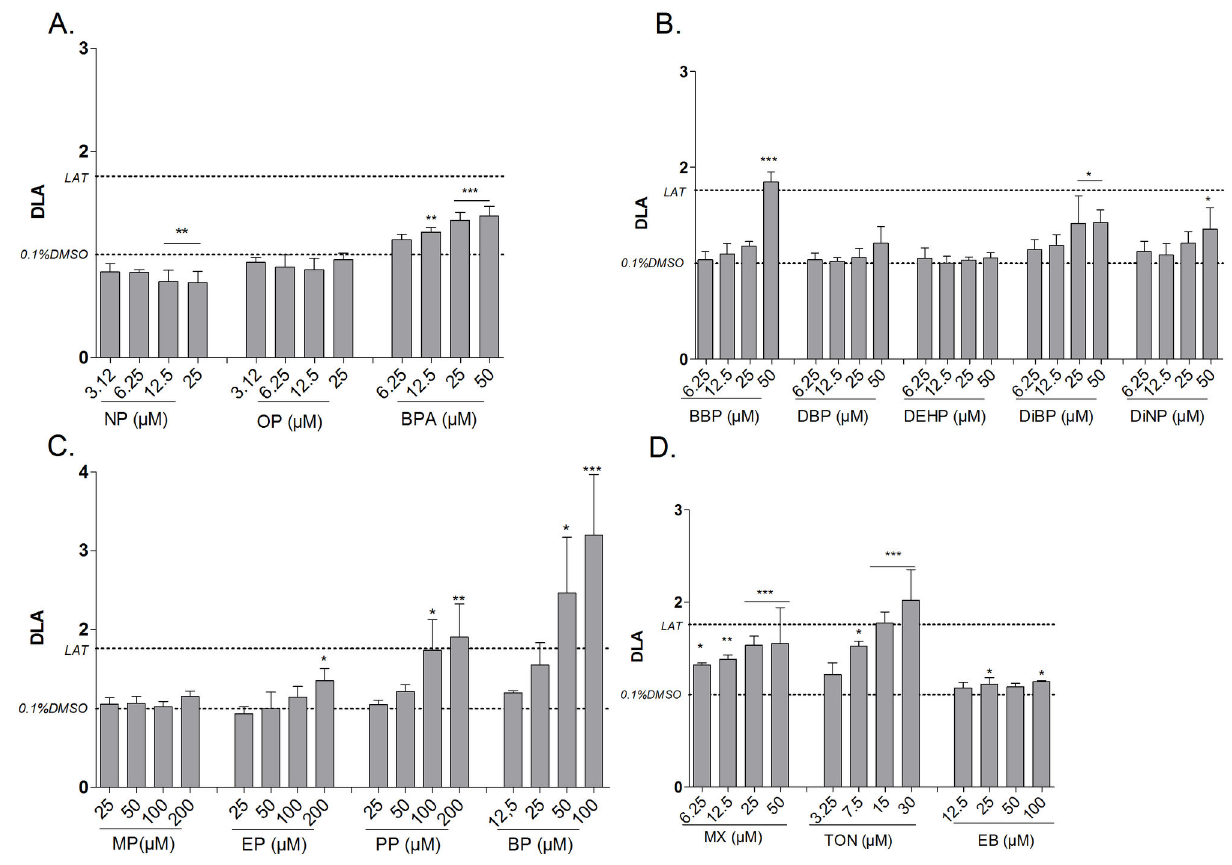
Figure 4. Effect of test compounds on adipocyte differentiation in 3T3-L1 cells after 10 days of exposure. Fluorimetric quantification of lipid accumulation was performed using Nile Red staining. The degree of lipid accumulation (DLA) induced by Alkylphenol (A.), Phthalate (B.) Paraben (C.) and Musk compound (D.) exposure are represented as mean (±SD) of three independent experiments (each with 4 replicates) (n=3). Significant differences with solvent control (0.1% DMSO) are indicated with asterisks (One Way ANOVA Dunnet’s post hoc test; *p≤0.05; **p≤0.01; ***p≤0.001). LAT: Lipid accumulation threshold . doi: